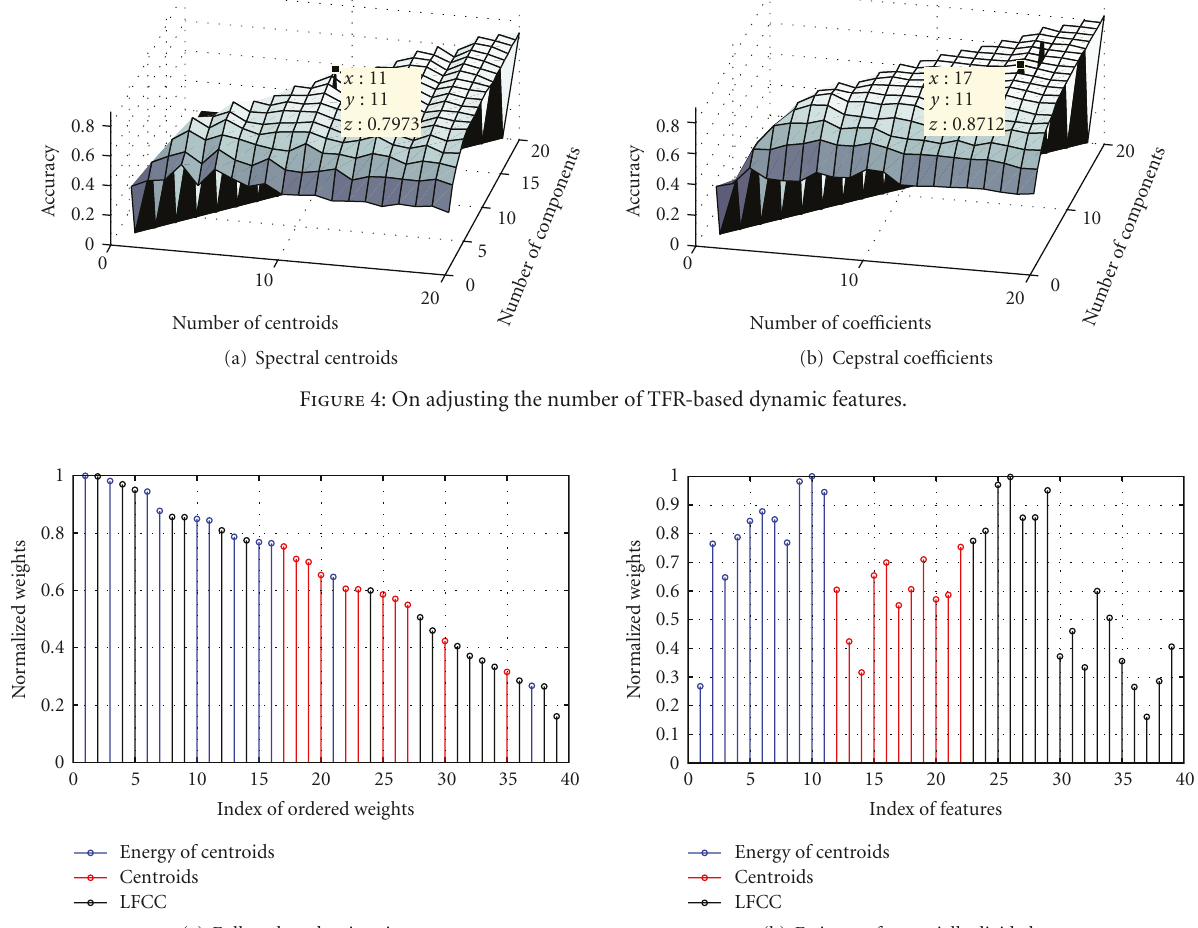
contours are chosen among the whole set of features no matter on their physical meaning. In this work, both com- bining approaches of dynamic features are studied in terms of dimension reduction, but also of accuracy